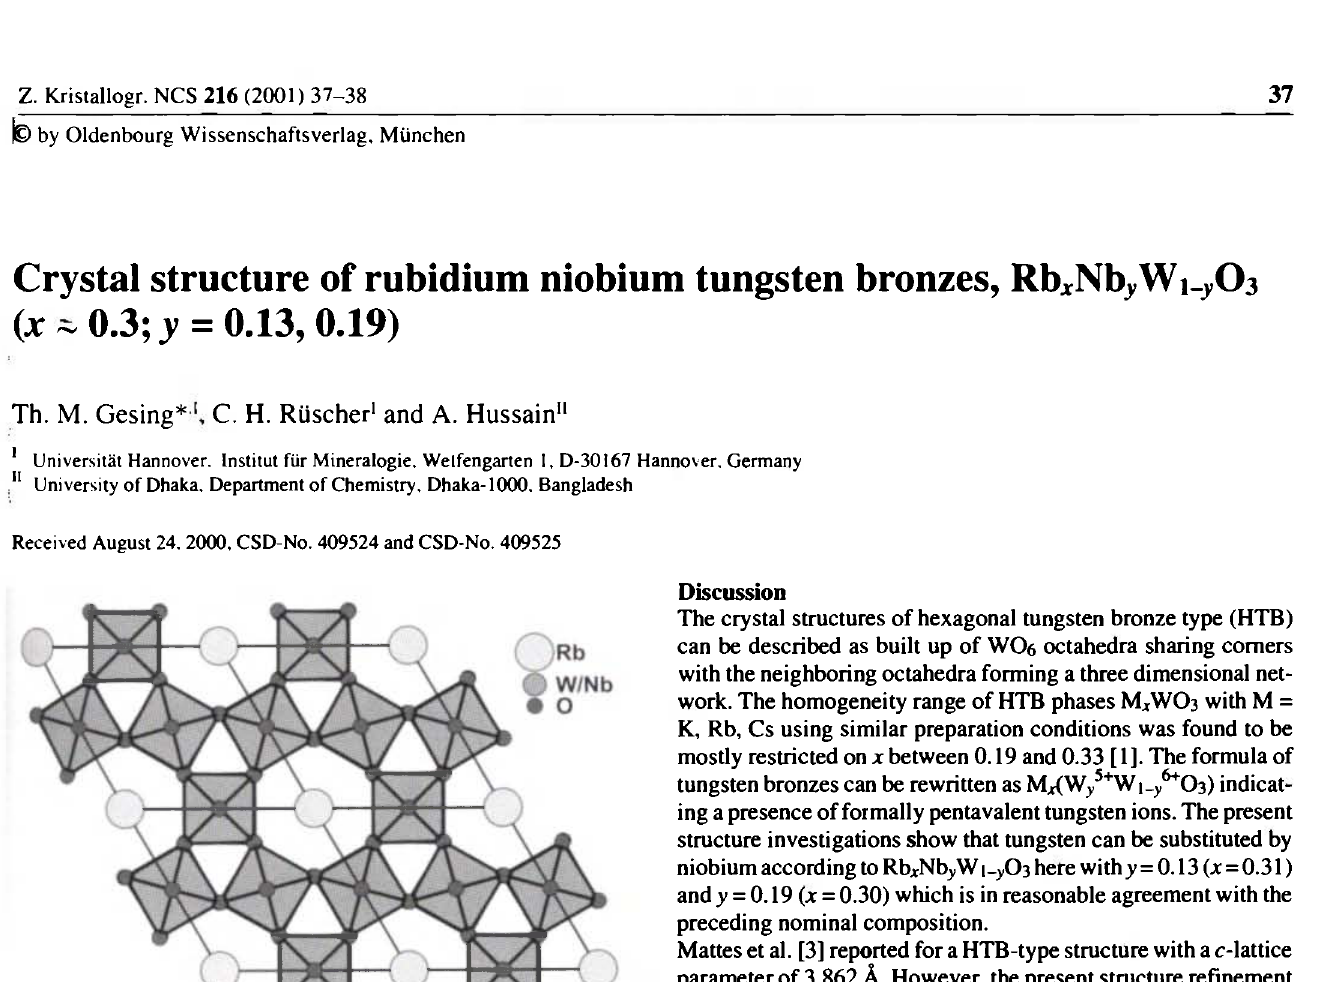
Table 1. Data collection and handling.